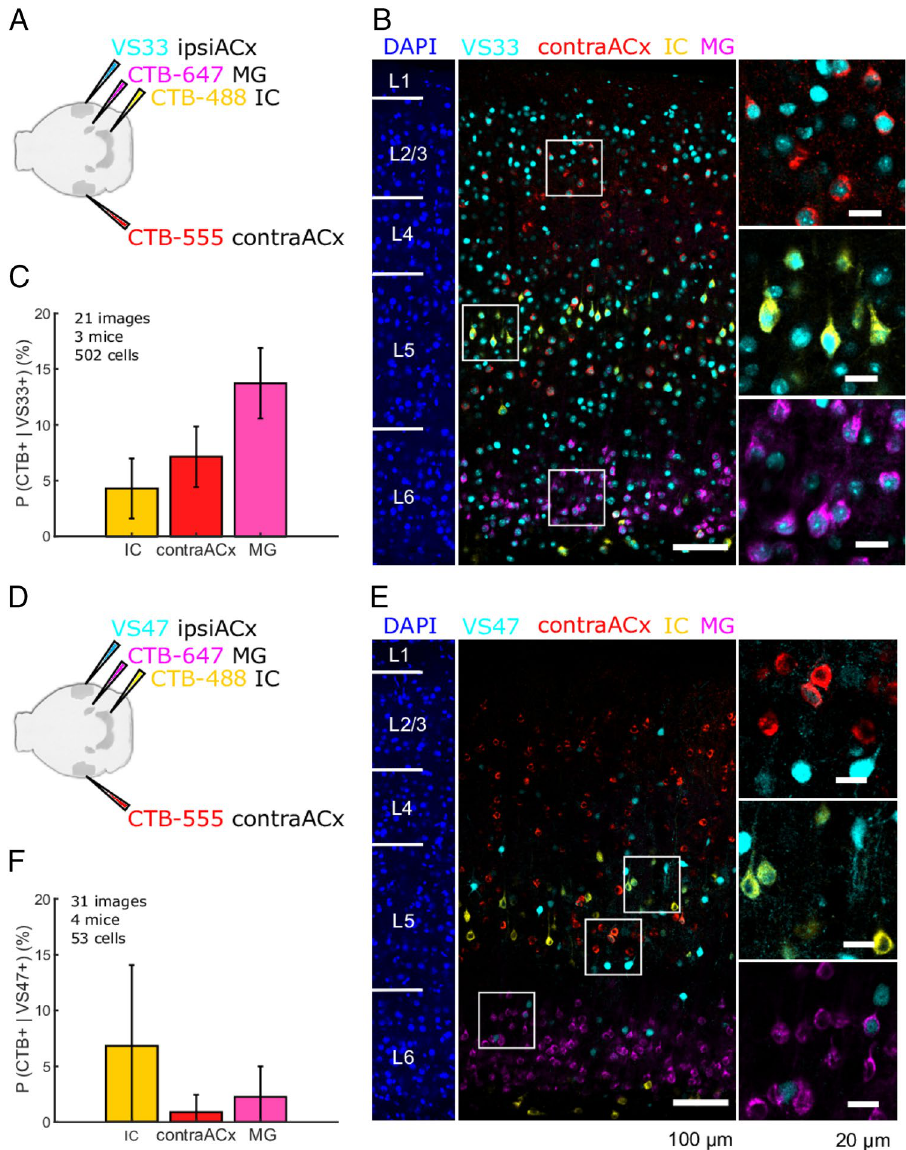
Figure 7. Projection patterns of neurons accessed with VS33 and VS47. ( A ) Schematic showing locations of the AAV8 capsid injections and the fluorescence colors for the VS33-driven mTFP reporter (cyan) and the CTB-conjugated fluorophores for retrograde labeling (red, yellow and magenta). ( B ) Multicolor fluorescence image of auditory cortex injected with AAV8 capsids containing VS33-driven mTFP (cyan), along with retrograde-labeled neurons projecting to the contralateral auditory cortex (red), the inferior colliculus (yellow) and the medial geniculate nucleus (magenta). Right panels are expansions of the insets. ( C ) Quantification of the percentage of VS33-positive cells that are co-stained by the CTB-conjugated fluorophores (mean across images ± SD). VS33 drives expression in projecting cortical cells which predominantly project to MG. ( D – F ) Analogous to ( A – C ), but for the VS47-driven mTFP reporter construct. VS47 drives expression in projecting cortical cells which predominantly project to IC. IpsiACx: Ipsilateral auditory cortex; contraACx: contralateral auditory cortex; IC: inferior colliculus; MG: medial geniculate